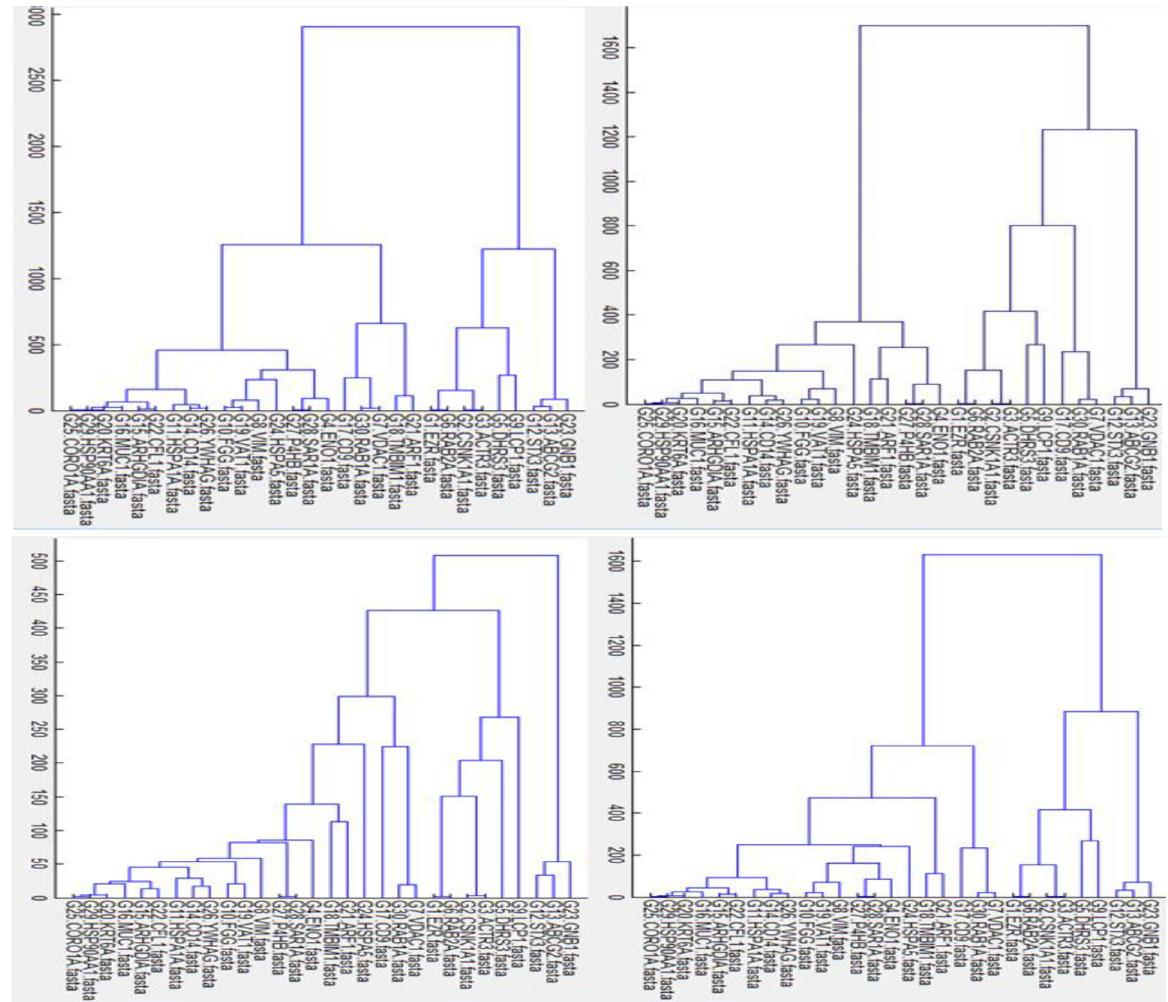
Fig 5. Single, median, complete and Average clustering based on discrete Fourier transform of gene DNA